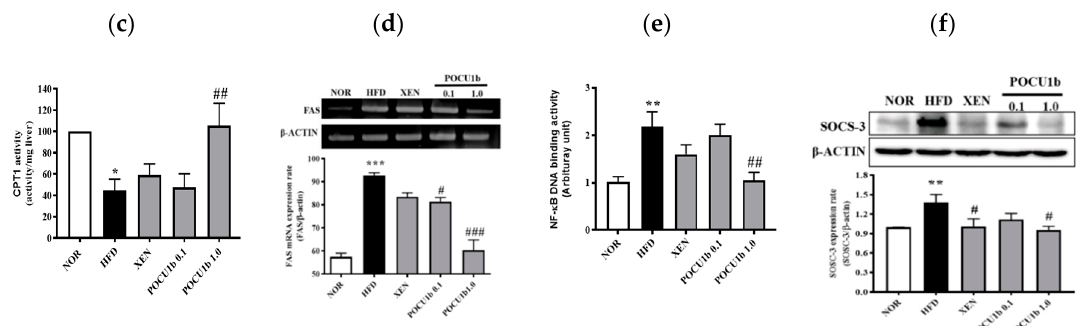
Figure 8. E ff ects of POCU1b on adenosine monophosphate-activated protein kinase (AMPK), phosphorylated (p)-AMPK, p-acetyl-CoA carboxylase (ACC), suppressor of cytokine signaling (SOCS)-3 protein and fatty acid synthase (FAS) mRNA expression, carnitine palmitoyl tranferase (CPT)-1, and NF- κ B DNA-binding activities in HFD-fed rat livers. ( a ) p-AMPK and AMPK levels, ( b ) p-ACC level, ( c ) CPT-1 activity, ( d ) FAS expression, ( e ) NF- κ B DNA-binding activity, and ( f ) SOCS-3 protein expression in the livers of rats of all treatment groups. Protein expression was measured by Western blot analysis. Relative mRNA expression level of FAS was measured by RT-PCR. * p < 0.05, ** p < 0.01, *** p < 0.001 vs. NOR, # p < 0.05, ## p < 0.01, ### p < 0.001 vs HFD.